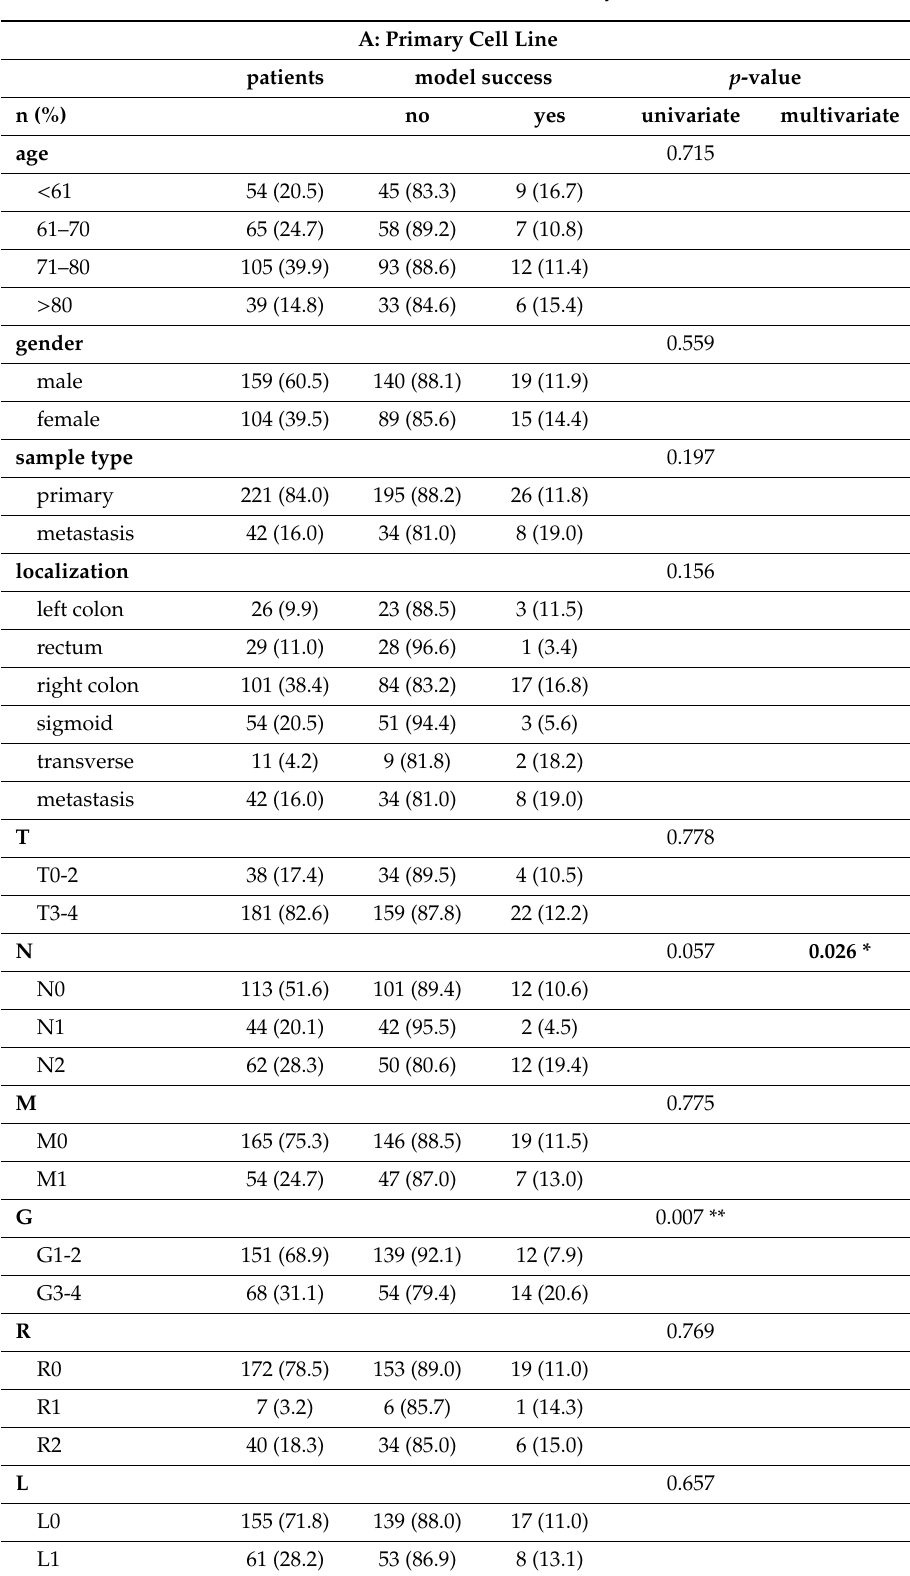
Table 2. Statistical correlation